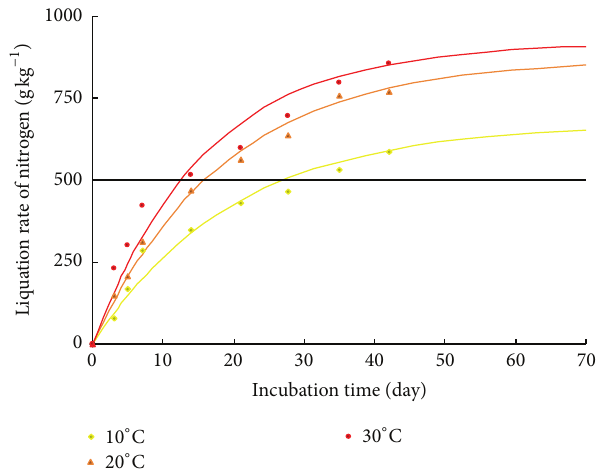
Figure 1: The accumulated nutrient leaching rate of BF at different temperatures.